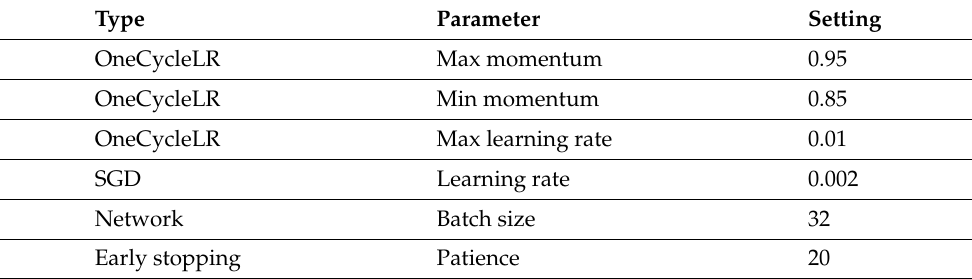
Table 2. The parameters and corresponding settings used in this study. Type